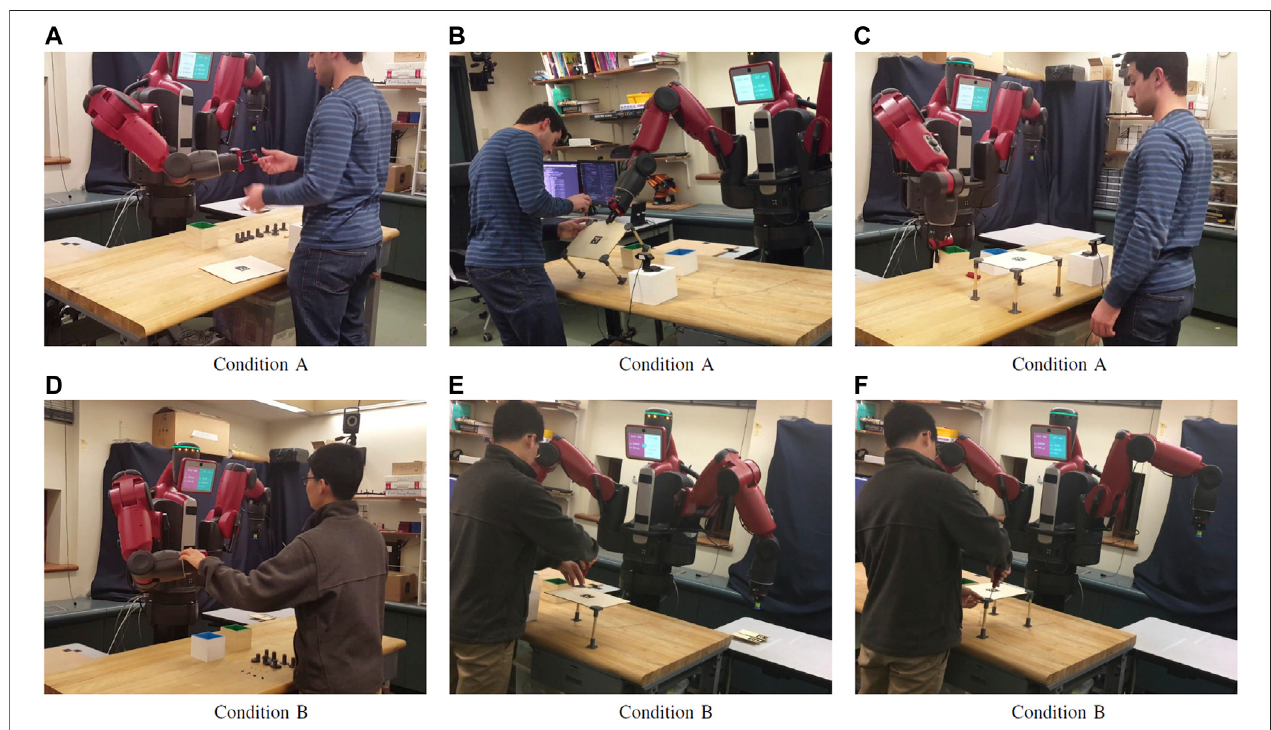
FIGURE 8 | Snapshots acquired during the collaborative assembly of the table in Condition A (full support, top) and Condition B (no holding required, bottom). Condition A(A – C) : 1)Baxter provides thetool totheparticipant; 2)the robot supports the humanbyholding thetabletop while thehuman screwsthe leg inplace;3) the user has fi nished his task and observes the robot freeing the workspace from the box of linkages. Condition B (D – F) : 1) The user signals to the robot that the holding action isnotrequired by pressing theerror button, and therobot acknowledges back bysignaling into its display thatitreceived thisinformation; 2) Thehold action is not performed any more, but other actions such asthe retrieval ofthe leg are still performed; 3) The human participant completes the execution ofthe task without the help of the robot, as requested.